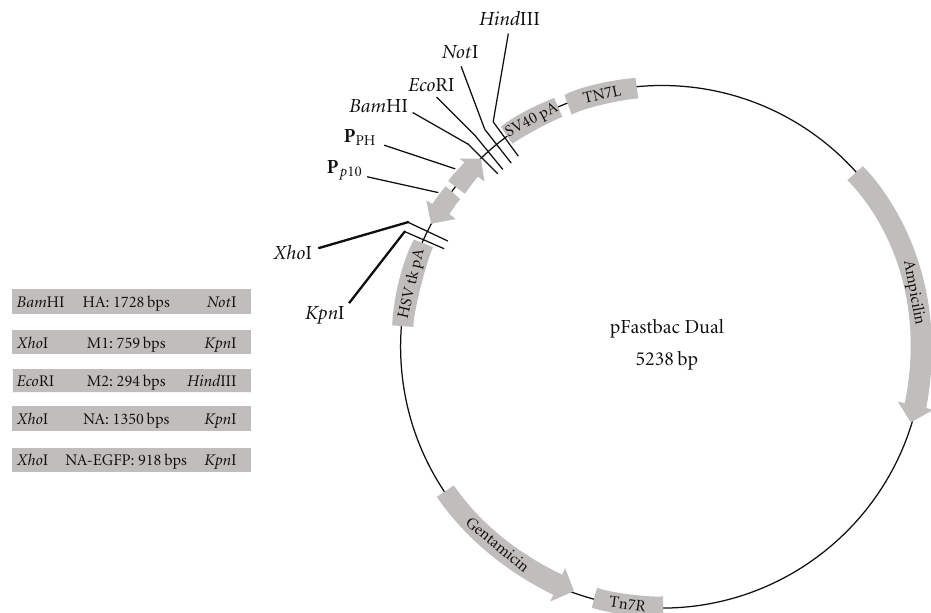
Figure 1: Construction of pFastbac Dual plasmid. Viral genes were flanked two di ff erent restriction sites while PCR amplification and ligated with pFastbac Dual vector as indicated. HA, M1 and M2, NA genes were paired and cloned in separate pFastbac Dual vectors and used for bacmids recombination. When constructing pFastbac Dual vectors for HA − and NA-EGFP VLPs, HA gene was omitted, and NA was replaced with NA-EGFP fusion gene, respectively. Tn7L and Tn7R were left and right arms of bacterial transposon Tn7 for gene